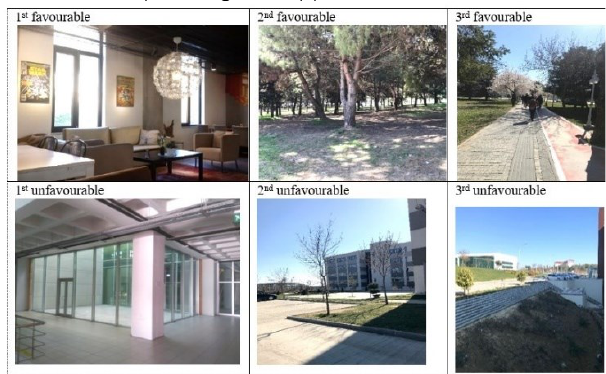
Table 6. Example photos were taken by students from a horizontal campus using PPM